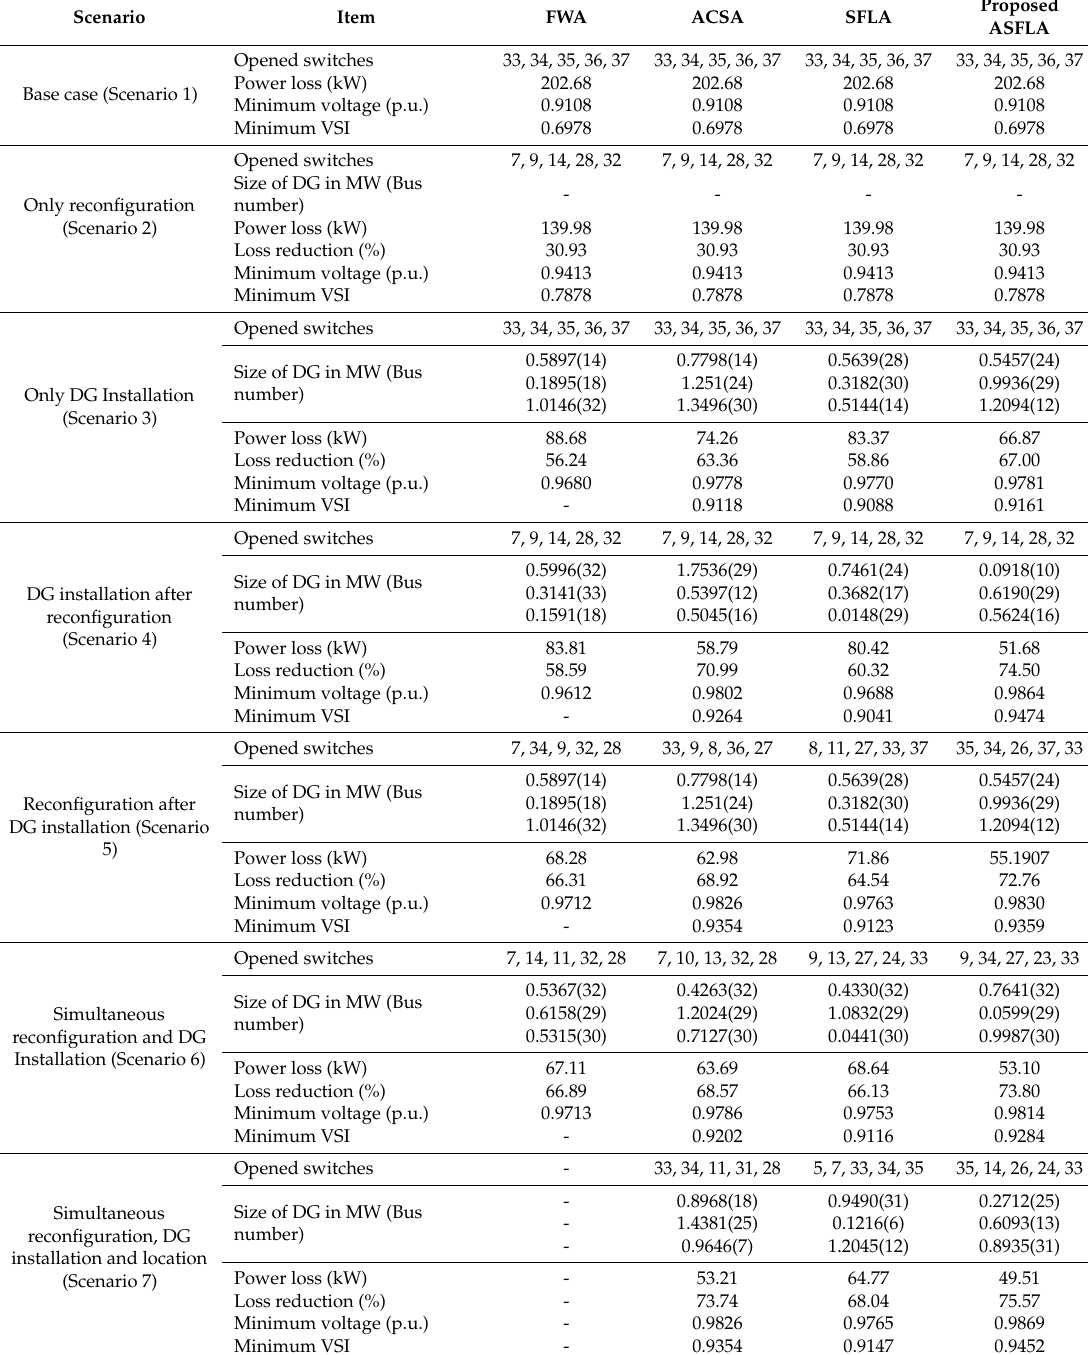
Table 1. Performance analysis of proposed ASFLA on the 33-bus